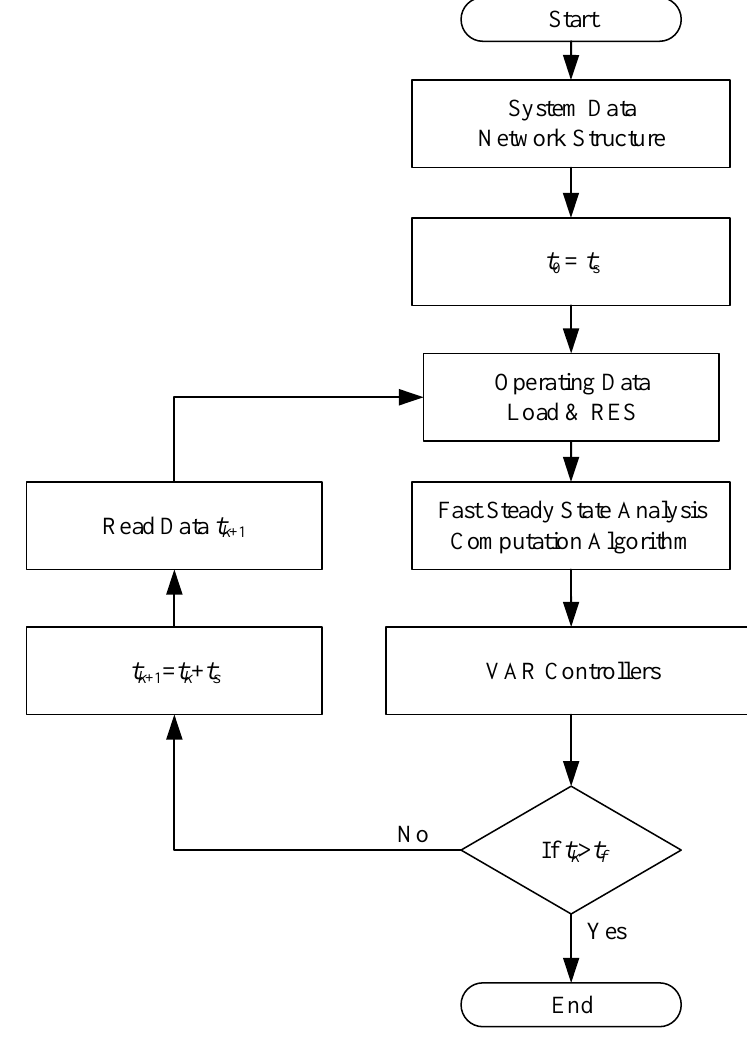
Figure 5. Fast QSTS time-series grid simulator.